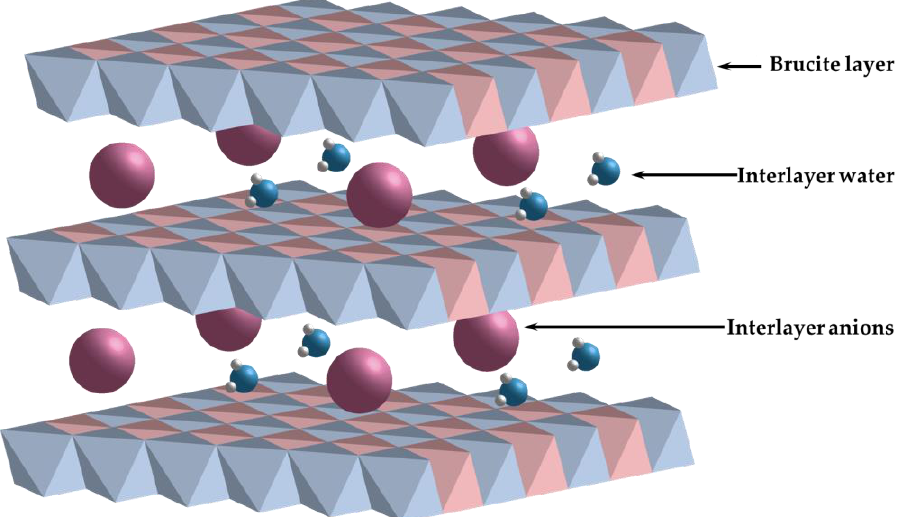
Figure 1. A Schematic illustration of LDH structure.